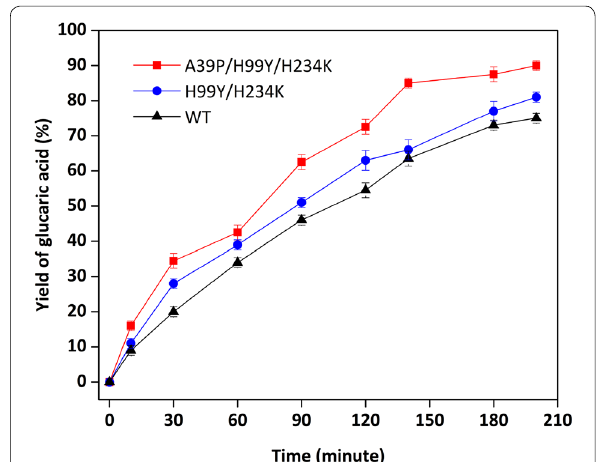
Fig. 6 Oxidative conversion of glucuronic acid to glucaric